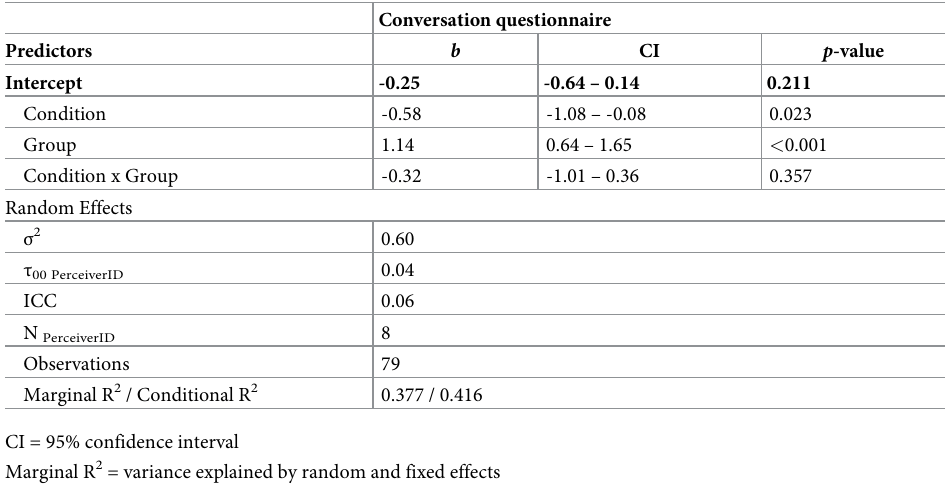
Table 6. Linear mixed model results for observer